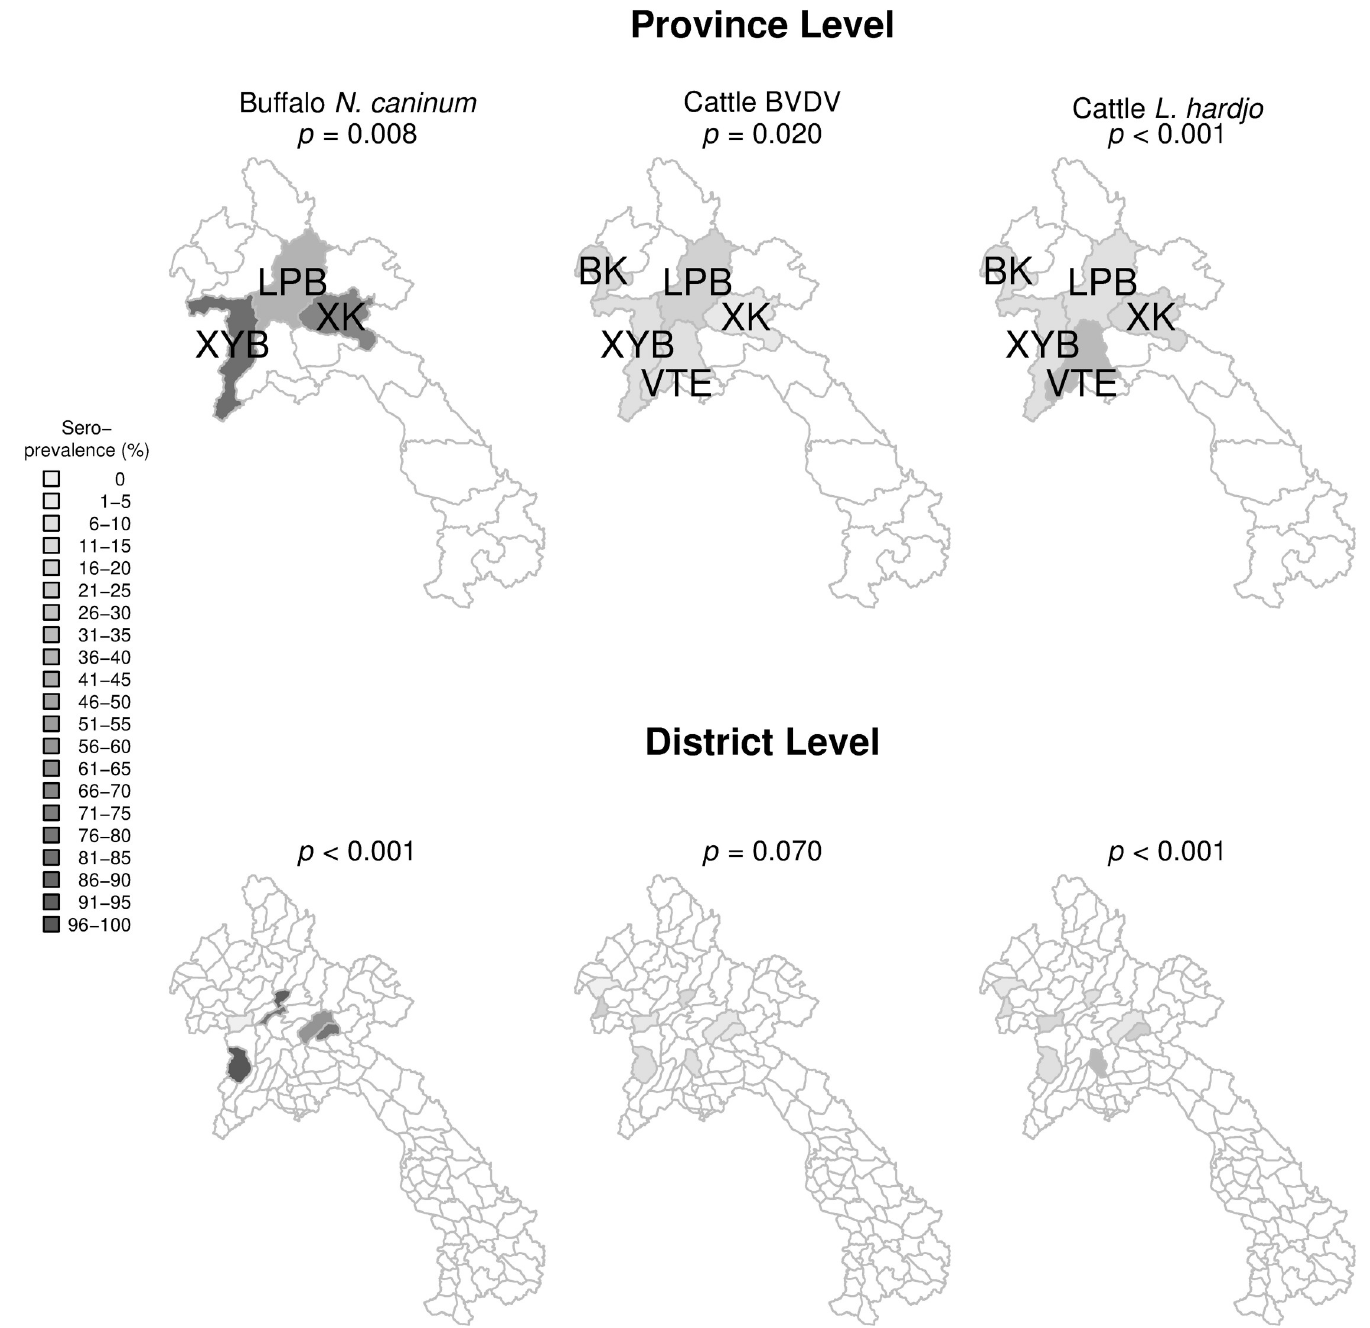
Fig 7. Spatial distribution heat map of buffalo Neospora caninum , cattle BVDV and cattle Leptospira interrogans serovar Hardjo ( L . hardjo ) antibodies in provinces in Lao PDR detected by enzyme-linked immunosorbent assay. Maps and Fisher exact tests to assess variation in sero-prevalence between provinces were generated using R statistical